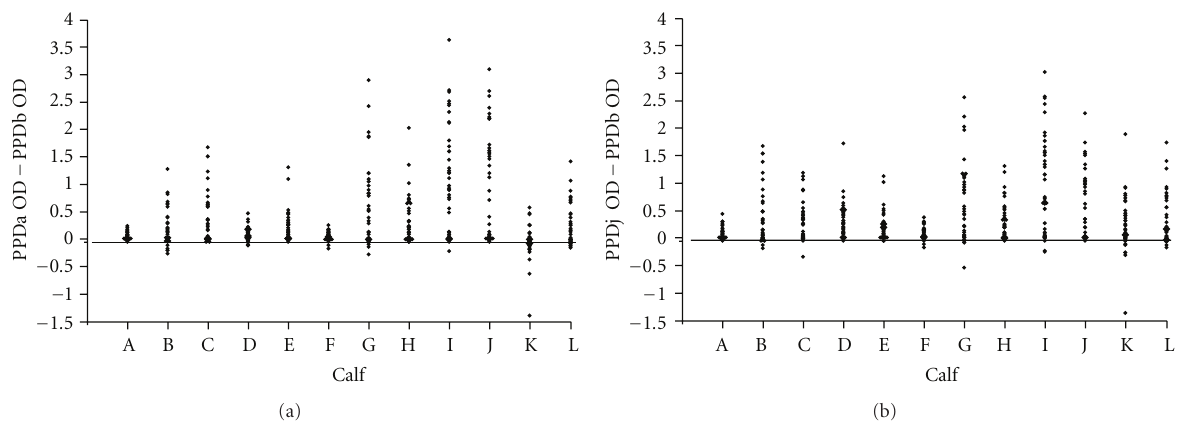
Figure 2: (a) Di ff erence between IFN- γ responses to PPDa and PPDb over the course of experiment 1 at weekly intervals with Map exposed cattle. A cut-o ff of (cid:21) 0.05 OD has been applied to highlight cattle with a higher response to PPDb than PPDa. (b) Di ff erence between IFN- γ responses to PPDa and PPDb over the course of experiment 1 at weekly intervals with Map-exposed cattle. A cut-o ff of − 0.05 OD has been applied to highlight cattle with a higher response to PPDb than